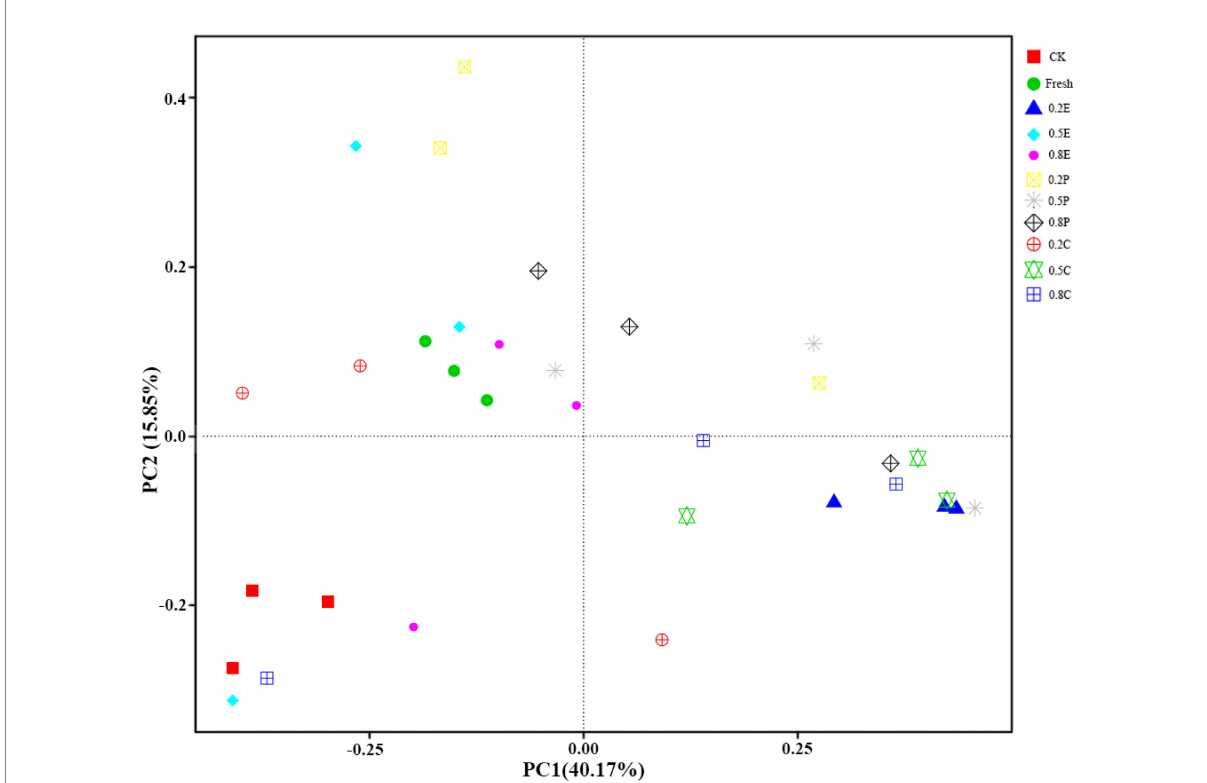
FIGURE 3 Principal coordinates analysis (PCoA) of bacterial communities of paper mulberry silage on day 60. CK, control; E, EDTA; P, propionic acid; C, citric acid; 0.2, concentration of additive is 2 g.kg − 1 FM; 0.5, concentration of additive is 5 g.kg − 1 FM; 0.8, concentration of additive is 8 g.kg − 1